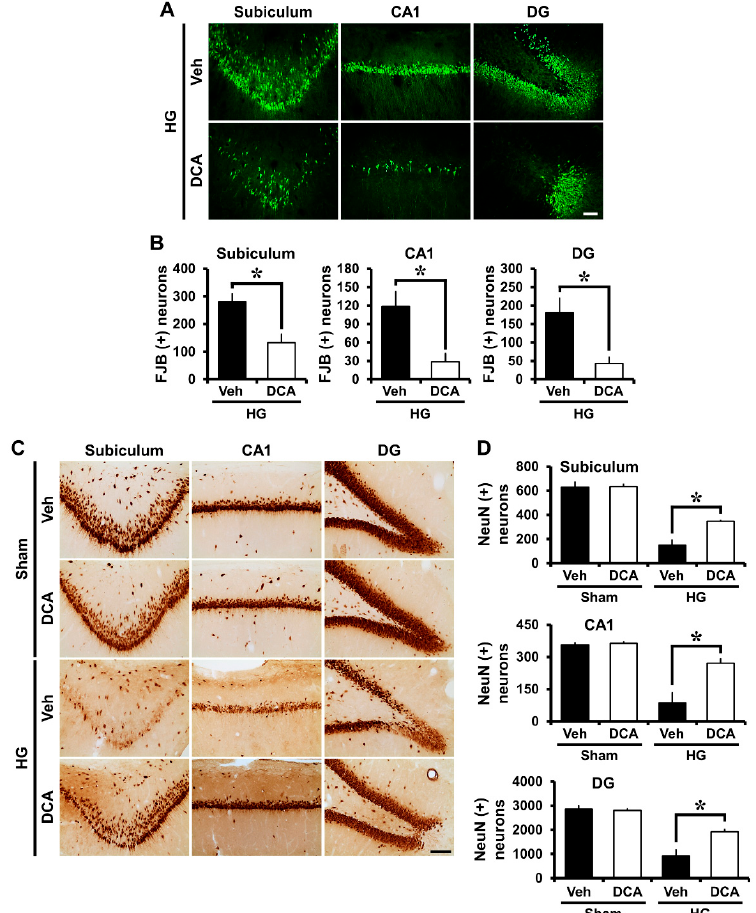
Figure 2. E ff ects of DCA on hypoglycemia-induced neuronal death. Hypoglycemia resulted in neuronal death in the subiculum (sub), CA1, and dentate gyrus (DG) of hippocampus one week after hypoglycemia. ( A ) Fluoro-Jade B (FJB) positive neuronal cells are observed in the CA1, subiculum, and DG one week after hypoglycemia. Scale bar = 50 µ m. ( B ) The number of FJB ( + ) cells were significantly lower in the DCA-treated group than that in the control group after insult. Data are mean ± S.E.M., n = 8 from each hypoglycemia group. ( C ) NeuN ( + ) cells show live neurons in the hippocampal subiculum, CA1 and DG. Scale bar = 100 µ m. ( D ) The number of NeuN ( + ) cells were considerably more increased in the DCA-treated group than in the control group after insult. Data are mean ± S.E.M., n = 3 for each sham group and hypoglycemia group. * Significantly di ff erent from vehicle treated group, p <